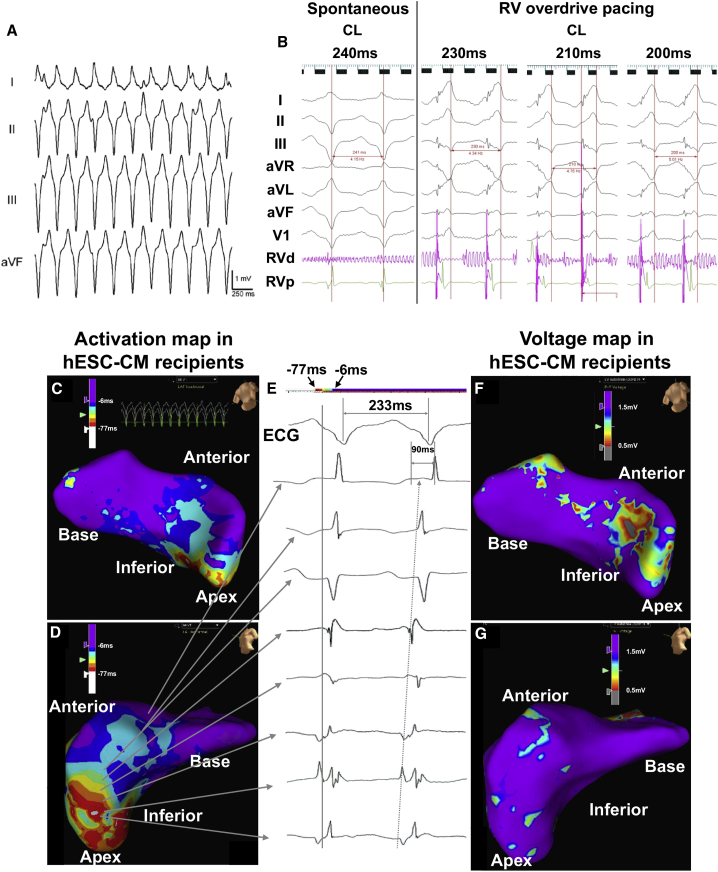
Electrophysiological Studies in hESC-CM Recipients during VTInfarcted pigs underwent EAM and standard clinical electrophysiological studies 10 days after delivery of vehicle or hESC-CMs.(A) Surface ECG recordings from a representative hESC-CM recipient in sustained monomorphic VT with a rate of 257 bpm and a superior axis, consistent with an origin in the apical LV.(B) Surface ECG traces acquired from a representative hESC-CM recipient during overdrive pacing from the right ventricular apex at varying pacing CLs. Note that the QRS complex of the paced beats always shows a fully paced morphology despite pacing at different CL with no evidence of progressive fusion or entrainment. After cessation of pacing maneuvers, the tachycardia continued with variable post-pacing intervals (not shown).(C and D) Septal (C) and anterolateral apical (D) views of an LV endocardial LAT map acquired from an infarcted hESC-CM recipient (P19) during VT displaying focal activation pattern with no evidence of macro-reentry. Areas of earliest activation are marked by white and red, while later-activating areas are depicted in a gradient from orange to yellow to green to blue.(E) Corresponding bipolar electrogram recordings and their respective location on the LV endocardial map of (D). The surface QRS (lead aVF) was used as the timing reference. Note that these local electrograms indicate a relatively wide area of early activation, suggesting a mid-myocardial origin in the apical LV.(F and G) Septal (F) and lateral (G) views of the corresponding LV endocardial voltage map with normal voltage being defined as >1.5 mV, abnormal as 1.5–0.5 mV, and dense scar as <0.5 mV. Areas of low voltage and localized scar are seen in the anterior apical septum. Note that the anterolateral endocardium shows predominantly normal voltages, indicating that the earliest area of VT activation (origin, D) is located in a region with preserved voltages.